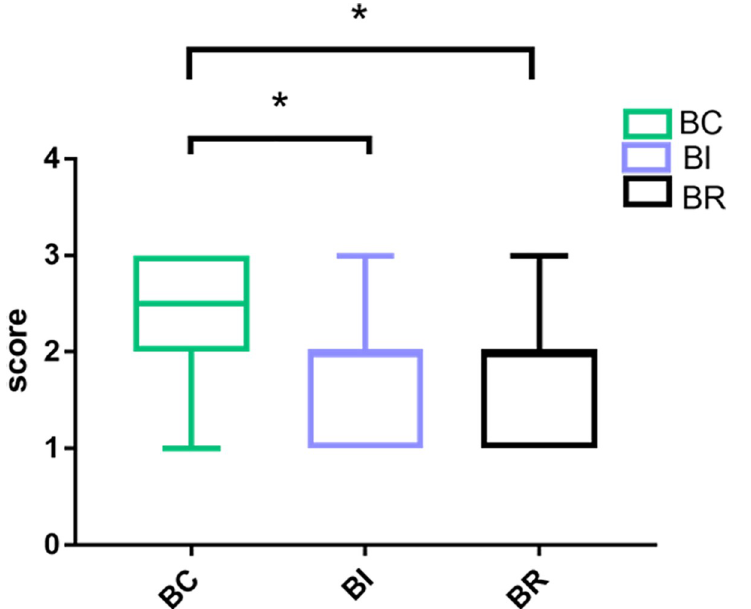
Fig 5. The subjective evaluation results of BC, BI and BR modes. � p < 0.05.